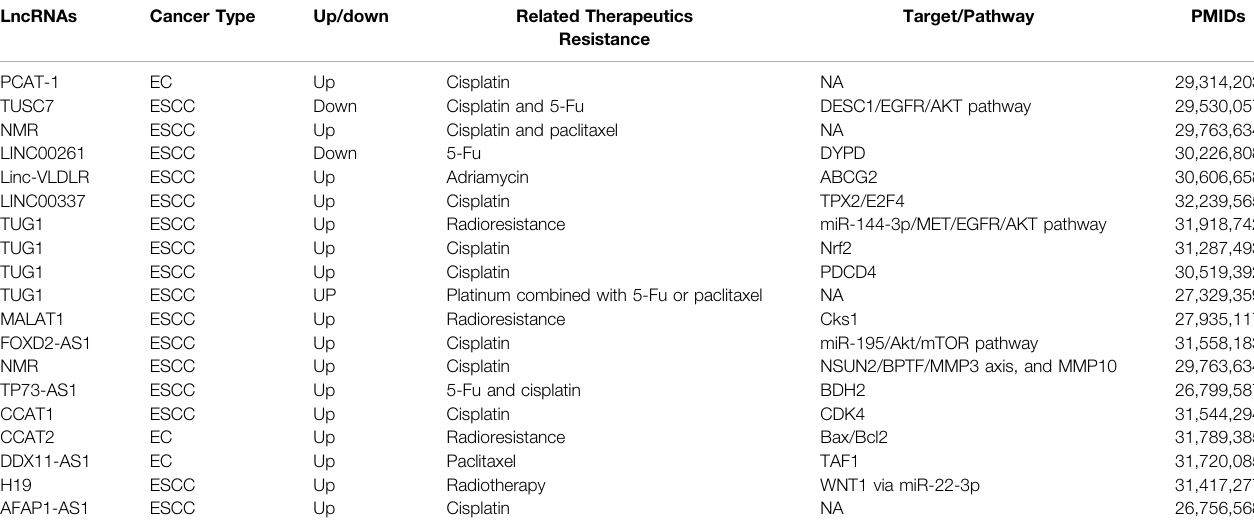
TABLE 5 | LncRNAs and drugs resistance/radioresistance in EC.